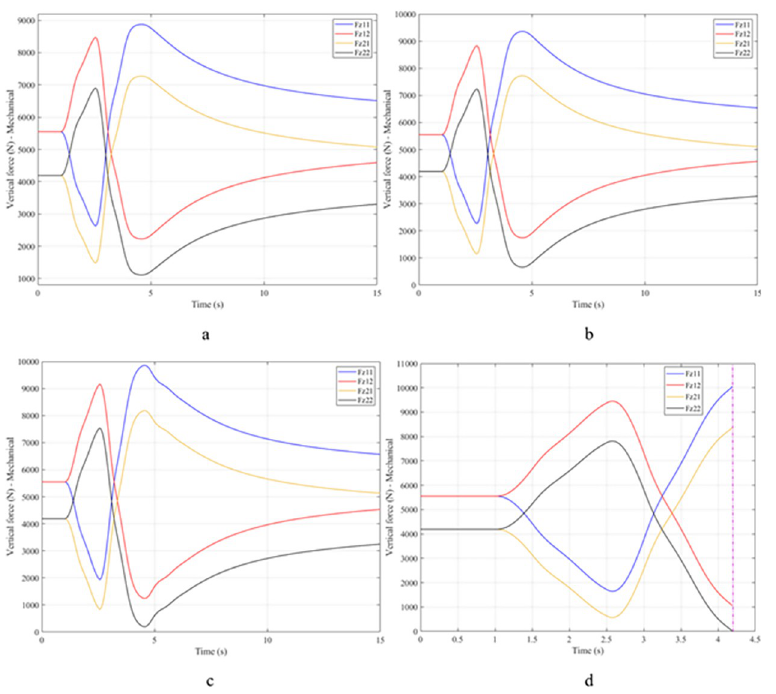
Fig 24. Vertical force–Mechanical.